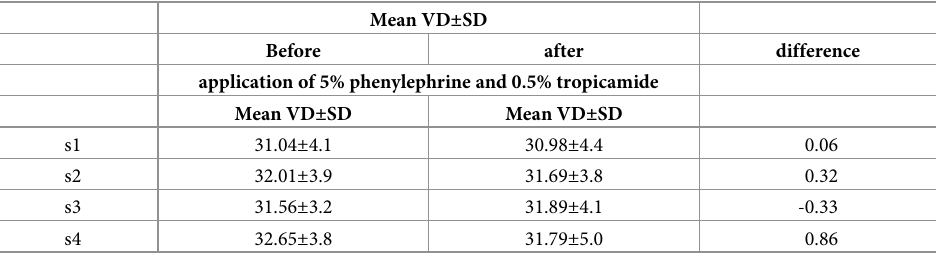
Table 2. Mean vessel density (VD), standard deviation (SD) and difference of VD before and after application of 5% phenylephrine and 0.5% tropicamide in the peripapillary region considering all 4